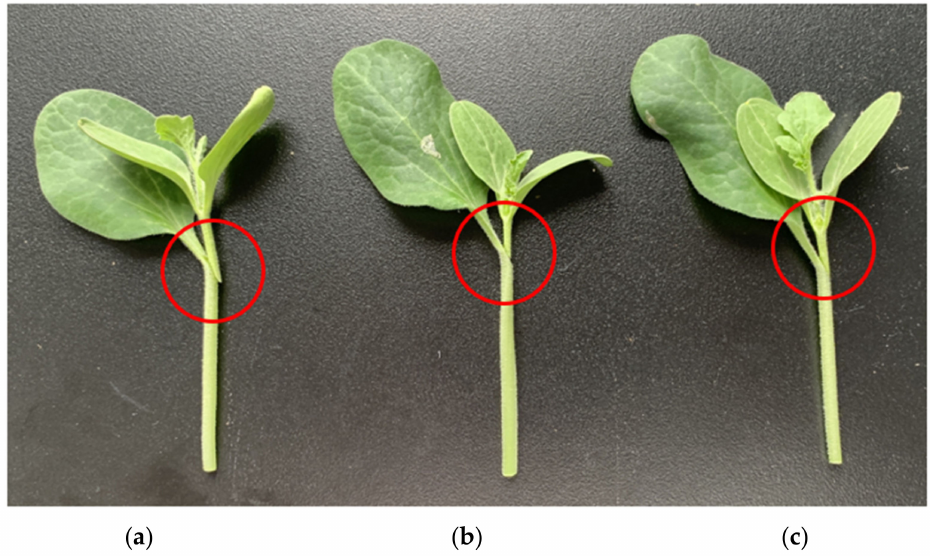
Figure 11. Fitting-precision comparison of different grafting methods: ( a ) manual grafting, ( b ) machine grafting, and ( c ) matched